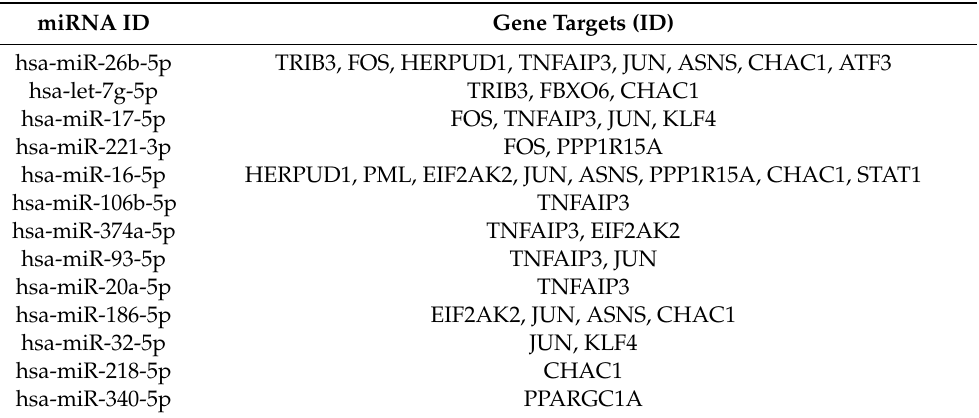
Table 7. EV associated miRNAs with decreased levels and their potential mRNA targets. miRNA ID Gene Targets